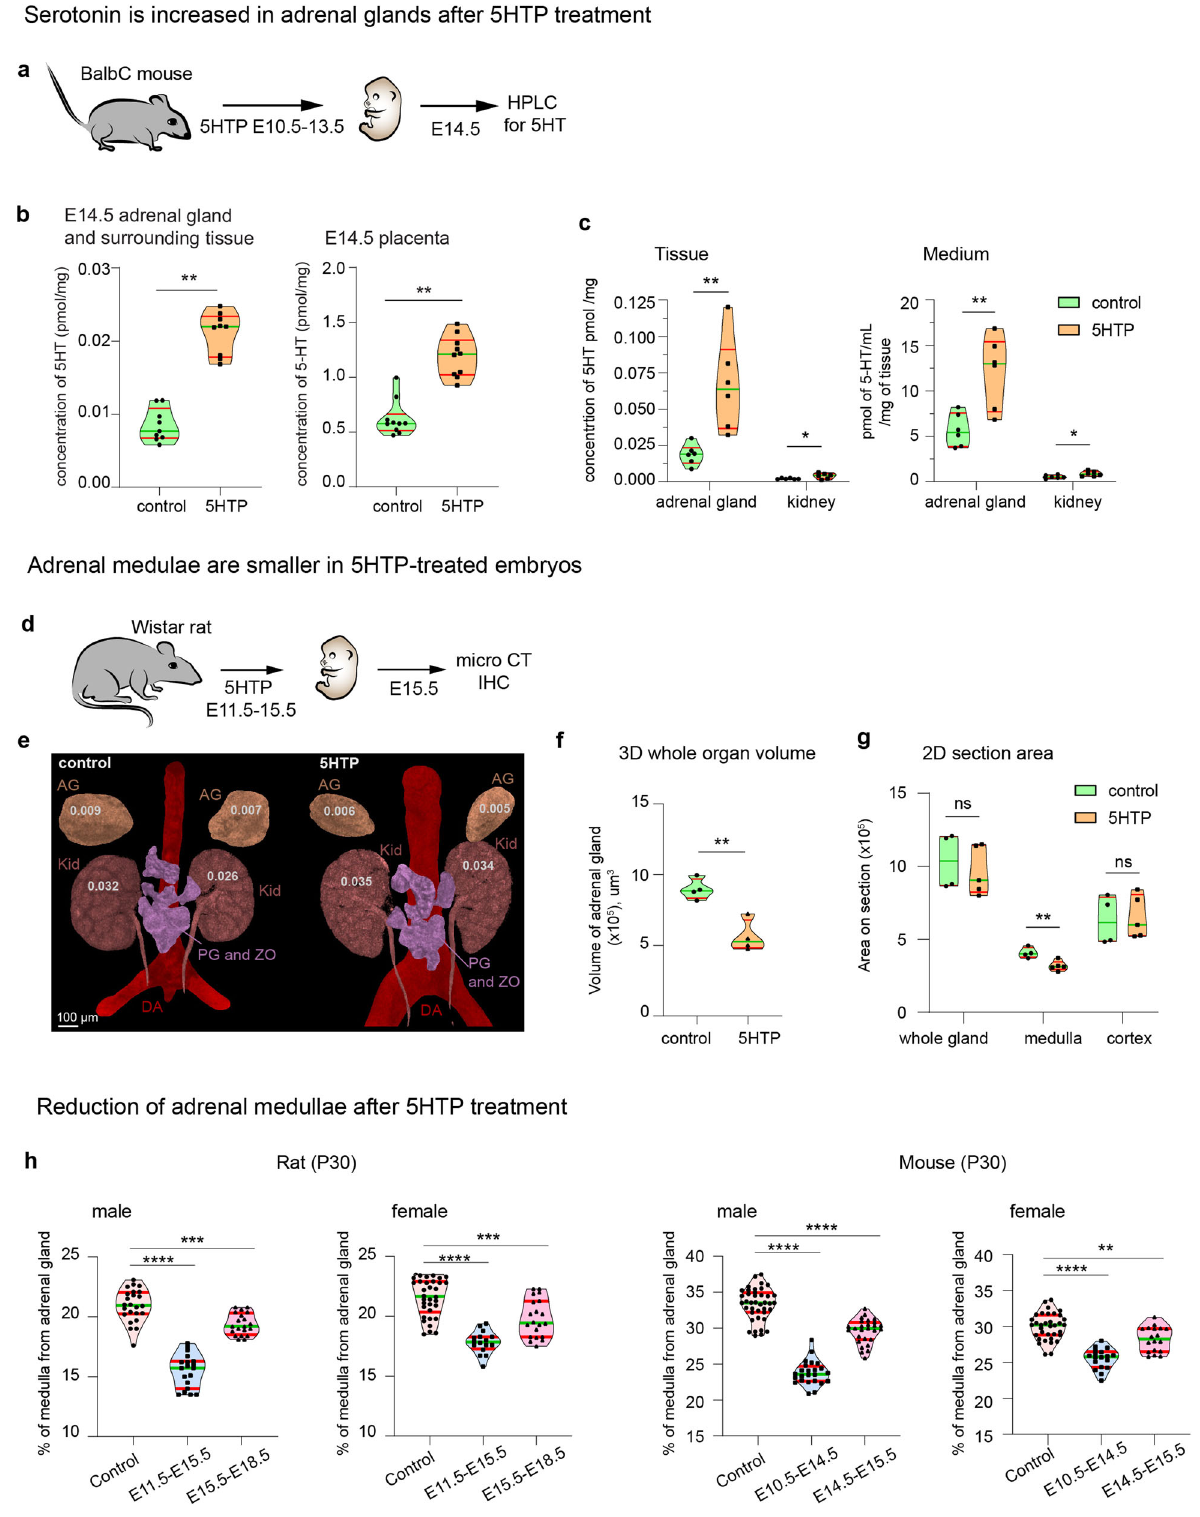
genes per cell on average). The general composition, cell type proportions, and the developmental sequence of cell types (SCPs, “ bridge ” cells, chromaf fi n cells, and sympathoblasts) (Fig. 5b, c) remained the same upon 5HTP treatment. At the same time, we detected a reliable change in expression of a gene responsible for